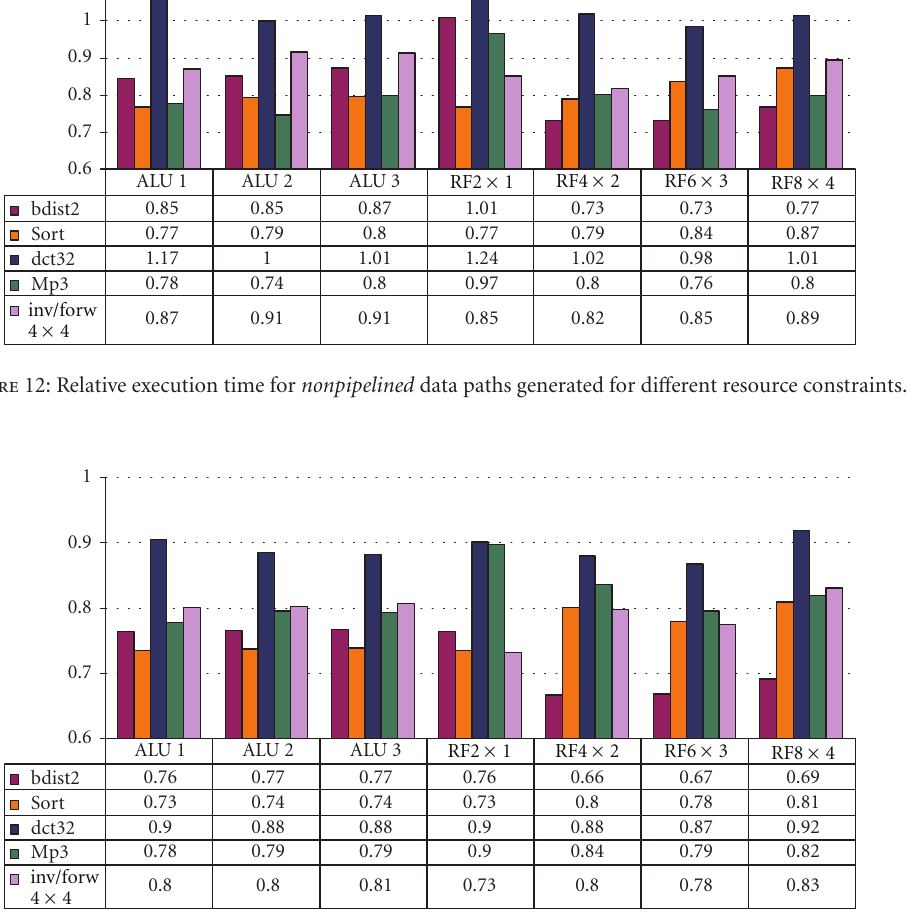
Figure 13: Relative execution time for Pipelined data paths generated for di ff erent resource